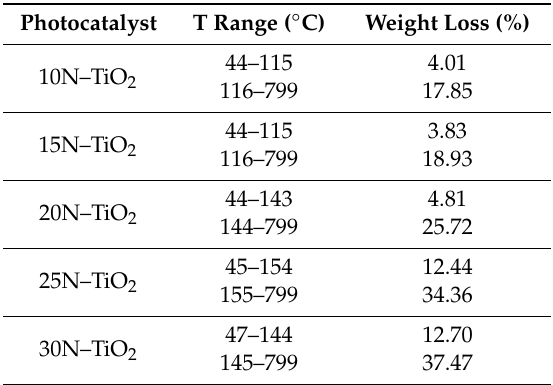
Table 1. Thermogravimetric analysis N–TiO 2 photocatalysts.